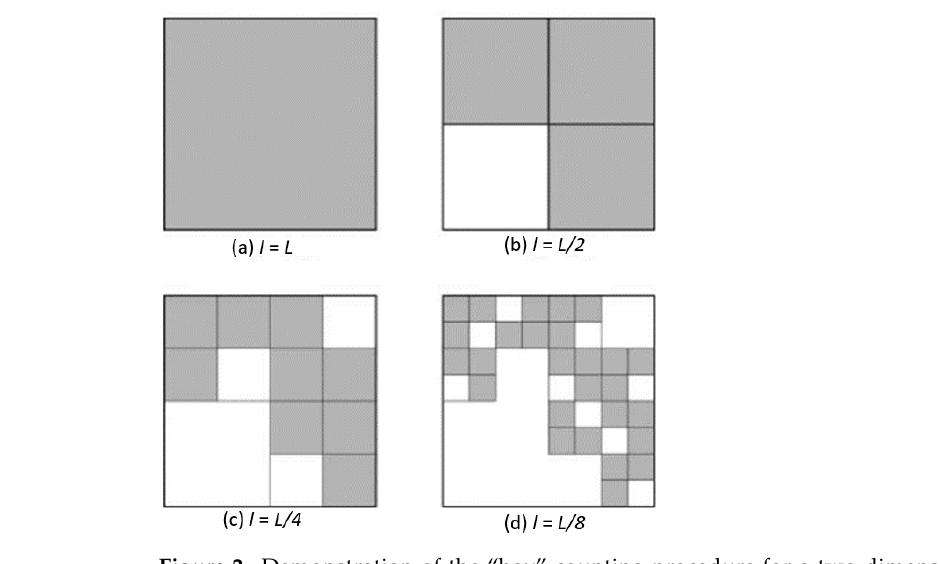
Figure 2. Demonstration of the “box” counting procedure for a two-dimensional fingering flow pattern. The shaded zones correspond to the boxes covering fingering.